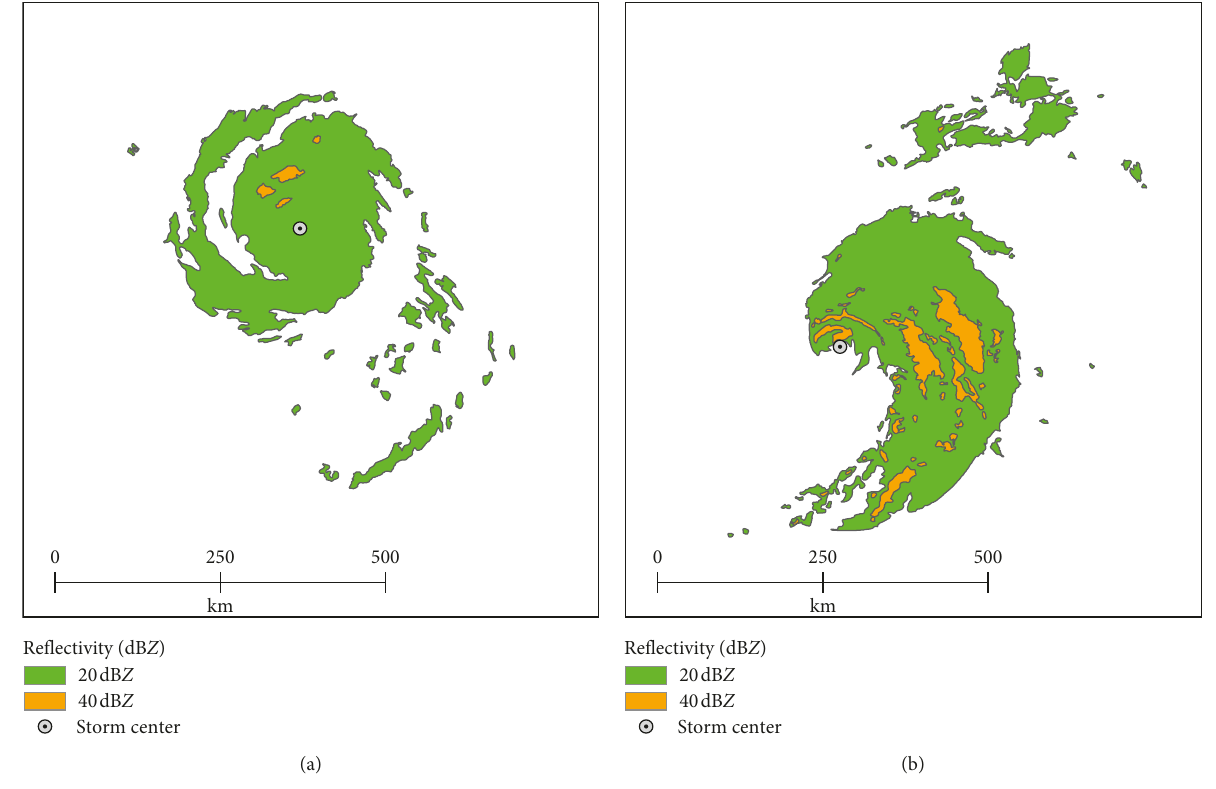
Figure 4: Reflectivity regions of 20 and 40dB Z at seven hours after landfall for (a) Jeanne and (b) Humberto.